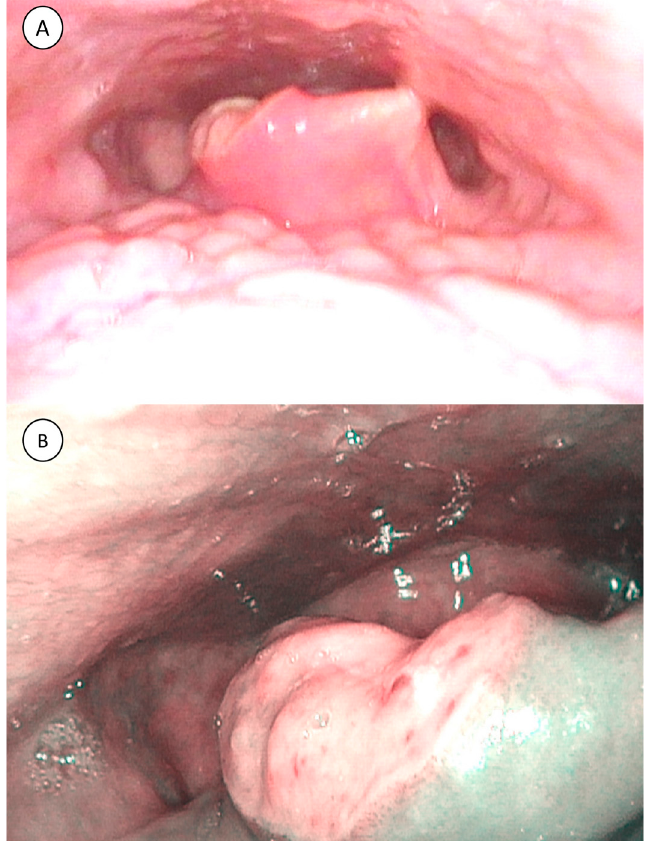
Figure 2. ( A ) The 38-year-old male presented with ulceration with chondritis over the right epiglottis; ( B ) right epiglottic ulcer in narrow-band imaging.